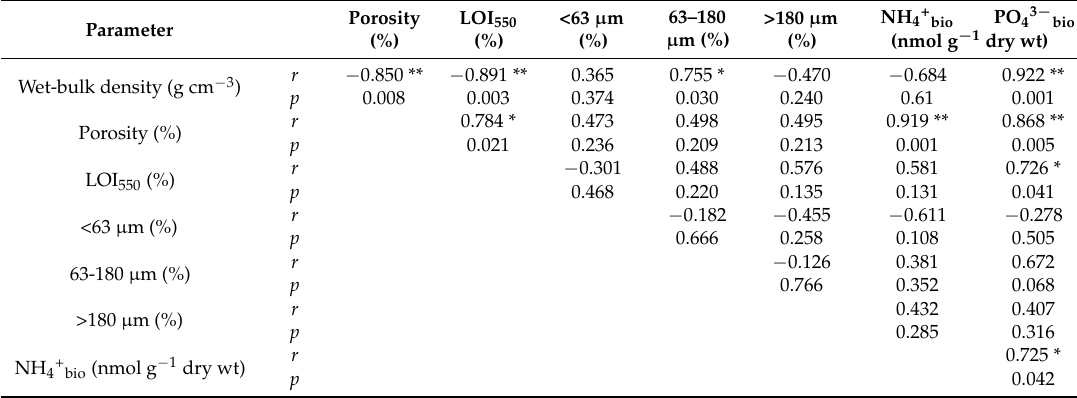
Table 2. Pearson correlation coefficients for physicochemical sediment parameters of the various depth horizons ( n = 8; * correlation significant at the 0.05 level (2-tailed); ** correlation significant at the 0.01 level